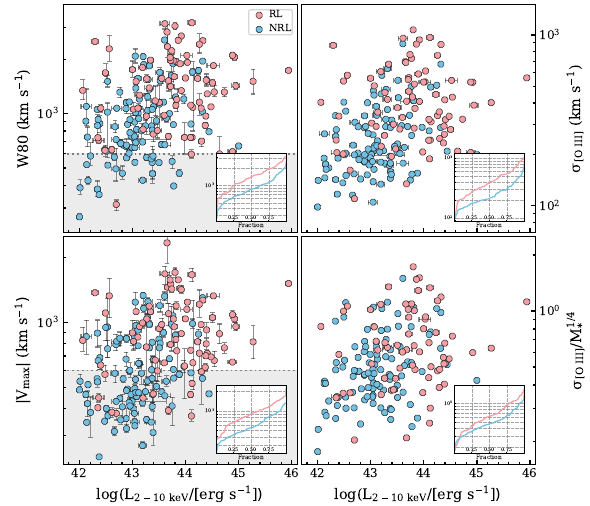
Figure 7. The distributions of the maximal velocity ( lower left ), velocity width ( upper left ), [O III ] ve- locity dispersion ( upper right ), and normalized [O III ] velocity dispersion ( lower right ), versus L 2 – 10keV . The red and blue circles exhibit the RL and NRL AGNs, respectively. The dotted lines and shaded regions indicate weak ionized outflows. In each panel, the inset plot compares the cumulative fraction between the RL and NRL AGNs.